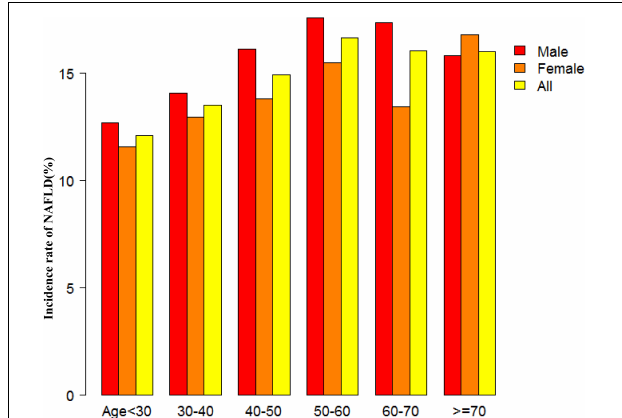
95%CI: 1.009–1.010), AST (HR = 1.011, 95%CI: